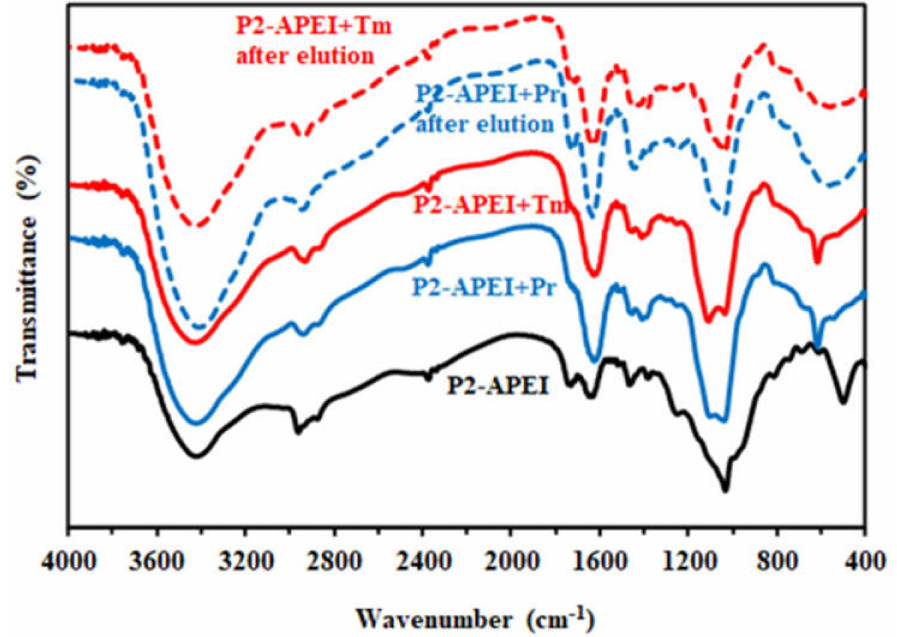
Figure 2. FTIR spectra of P2-APEI, P2-APEI sorbent loaded with Pr(III) and Tm(III), and after metal